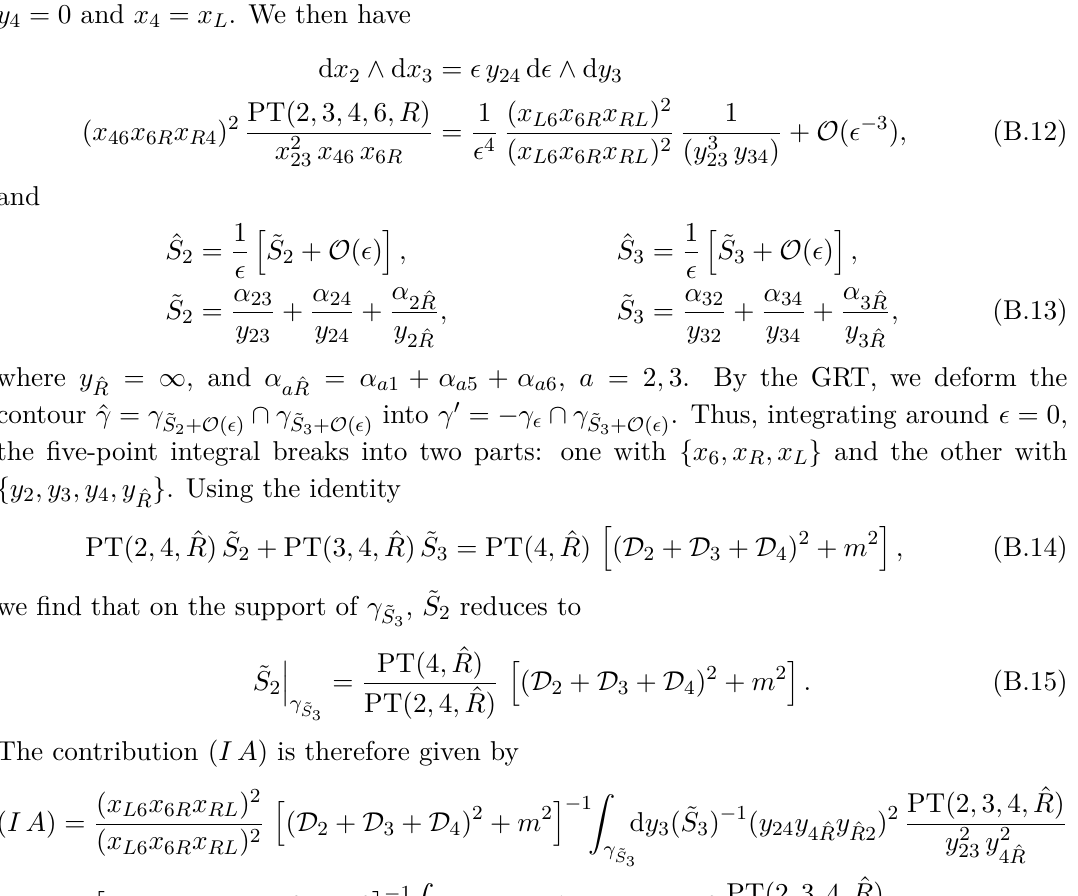
(cid:12) (cid:12) (cid:12) ( I )